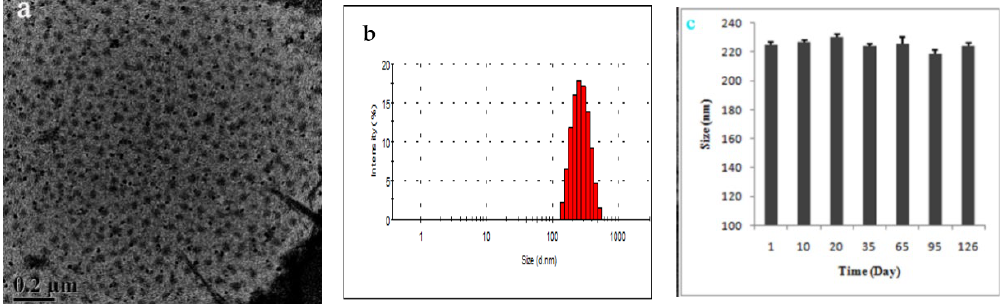
Figure 3. TEM images ( a ), size distribution ( b ), and size stability with time ( c ) of cationic amphiphilic HT 42 − CS − DCA 3.2 nanoparticles in PBS (2 mg/mL) at room temperature.